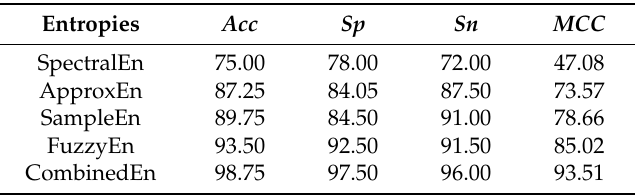
Table 1. The classification results. Acc : accuracy; Sn : sensitivity; Sp : specificity; MCC : Mathew´s correlation